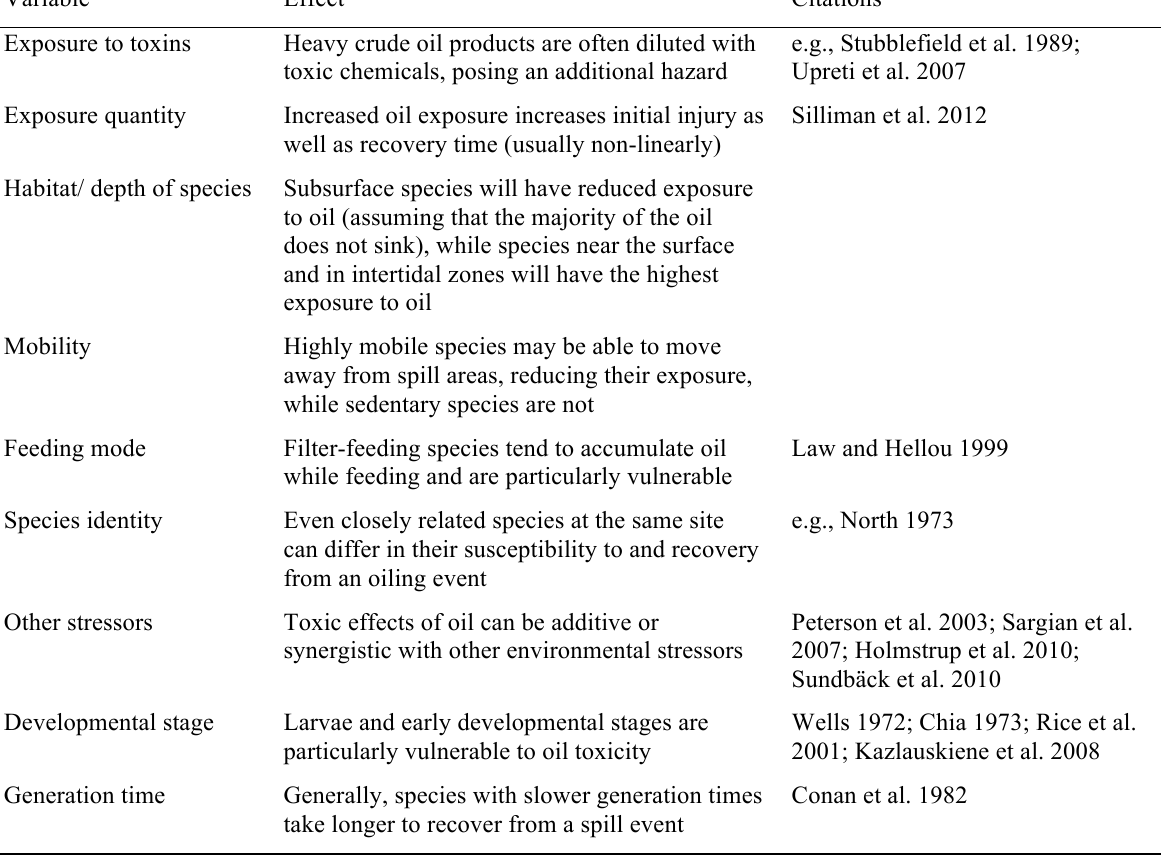
Table A1.4 Marine biology